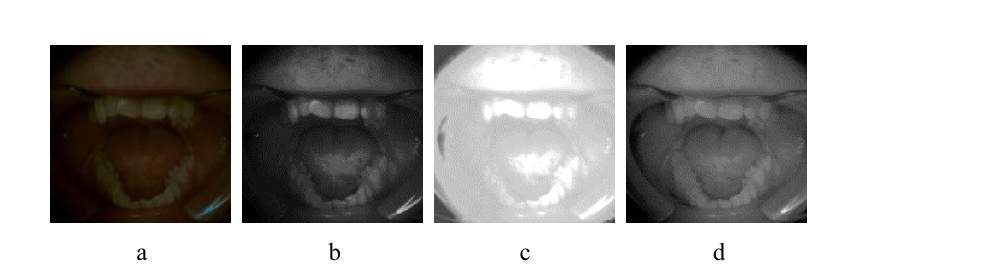
Figure 5. Adjustments in the illumination map for the ( a ) input, ( b ) is Original illumination, and, ( c ) & ( d ) shows the illumination map adaptations.